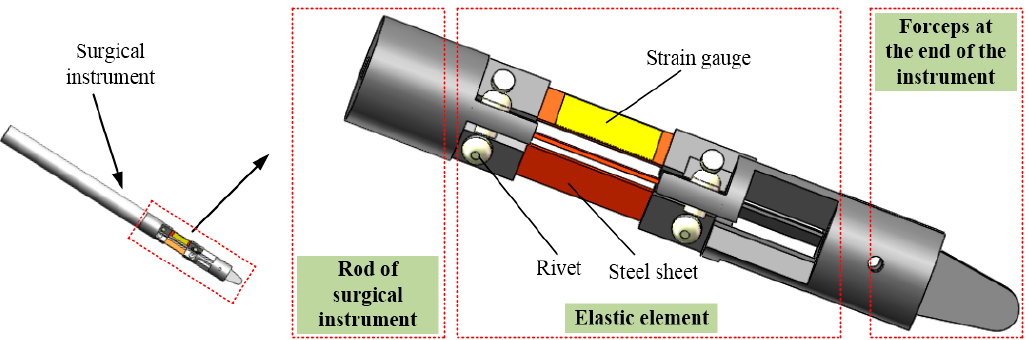
Figure 3. Three-dimensional model of elastic structure.